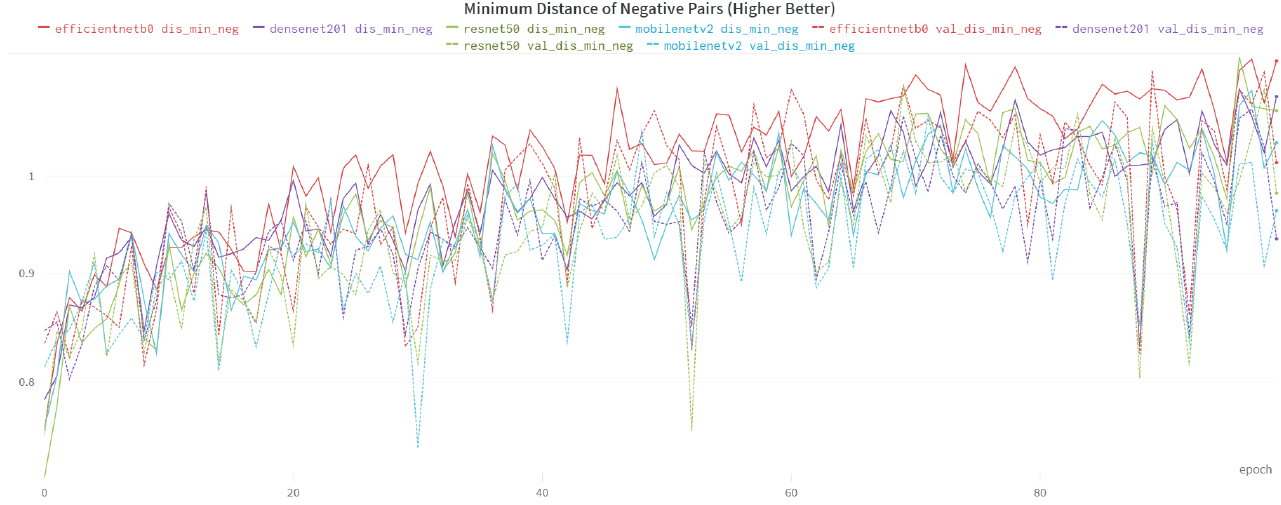
Figure 10. The comparison of the maximum distance of positive pairs among ResNet50, DenseNet, MobileNetV2, and